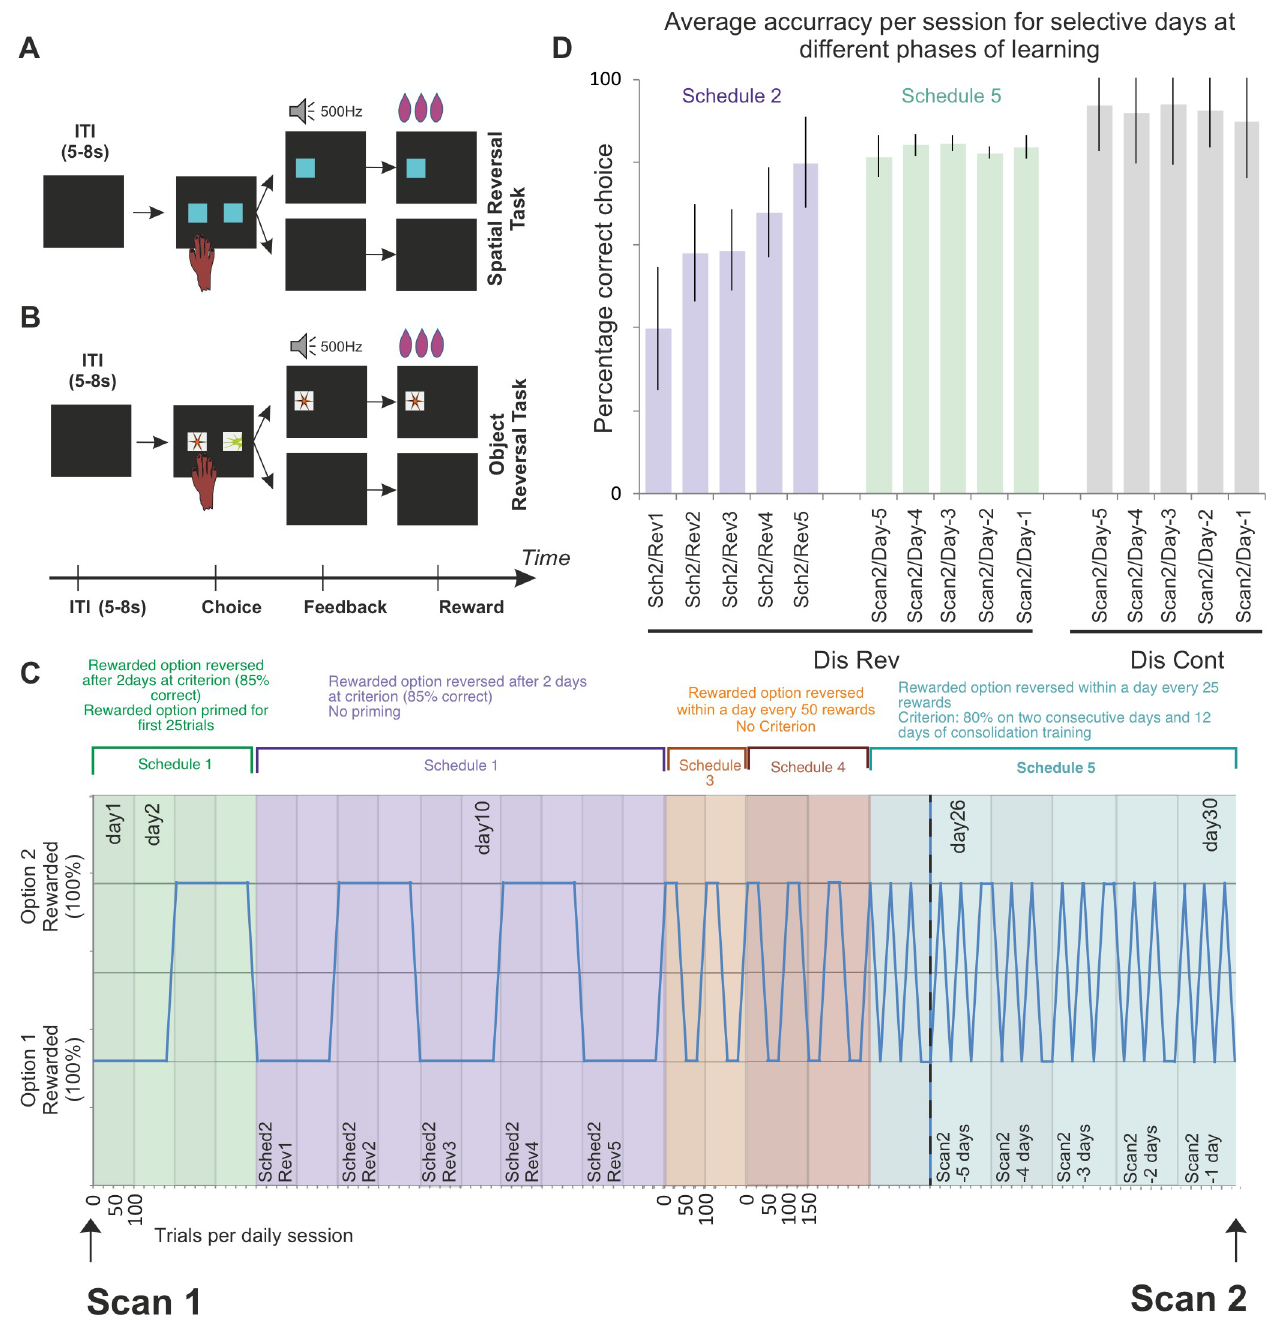
Fig 1. Trial structure in (A) spatial DisRev, (B) object DisRev, and (C) overview of DisRev experience between structural scan 1 and 2 in a longitudinal investigation of the effect of learning on brain structure and function. The schematic illustrates an ideal performer. The minimum number of trials needed by an ideal performer per daily session is illustrated on the abscissa, and reward properties of the two options are plotted on the ordinate. All reversal tasks were deterministic (in any given period, one option was always rewarded when chosen, and the other option was never rewarded when chosen). In the first testing schedules, animals completed 100 trials per day, and one of two simultaneously presented options was designated the rewarded target for the day. In schedule 1, the rewarded choice was primed for 25 trials before introducing, in addition, the unrewarded choice on the opposite side of the screen for an additional 75 trials. The choice–reward contingencies were reversed the day after each animal performed above 85% correct for two consecutive days. Schedule 2 was similar, but now the rewarded choice was not primed. Animals experienced five reversals under schedule 2. With perfect performance, an animal could, therefore, complete this second phase in 10 days. Schedules 3 and 4 introduced a choice–reward association reversal within a given day’s testing session; the reversal occurred once the animal had correctly chosen the target 50 times. The animals completed 2 days of 100 trials and 3 days of 150 trials on schedules 3 and 4, respectively. There was no performance criterion in these phases. As such, schedules 3 and 4 were not goals in themselves but stepping stones